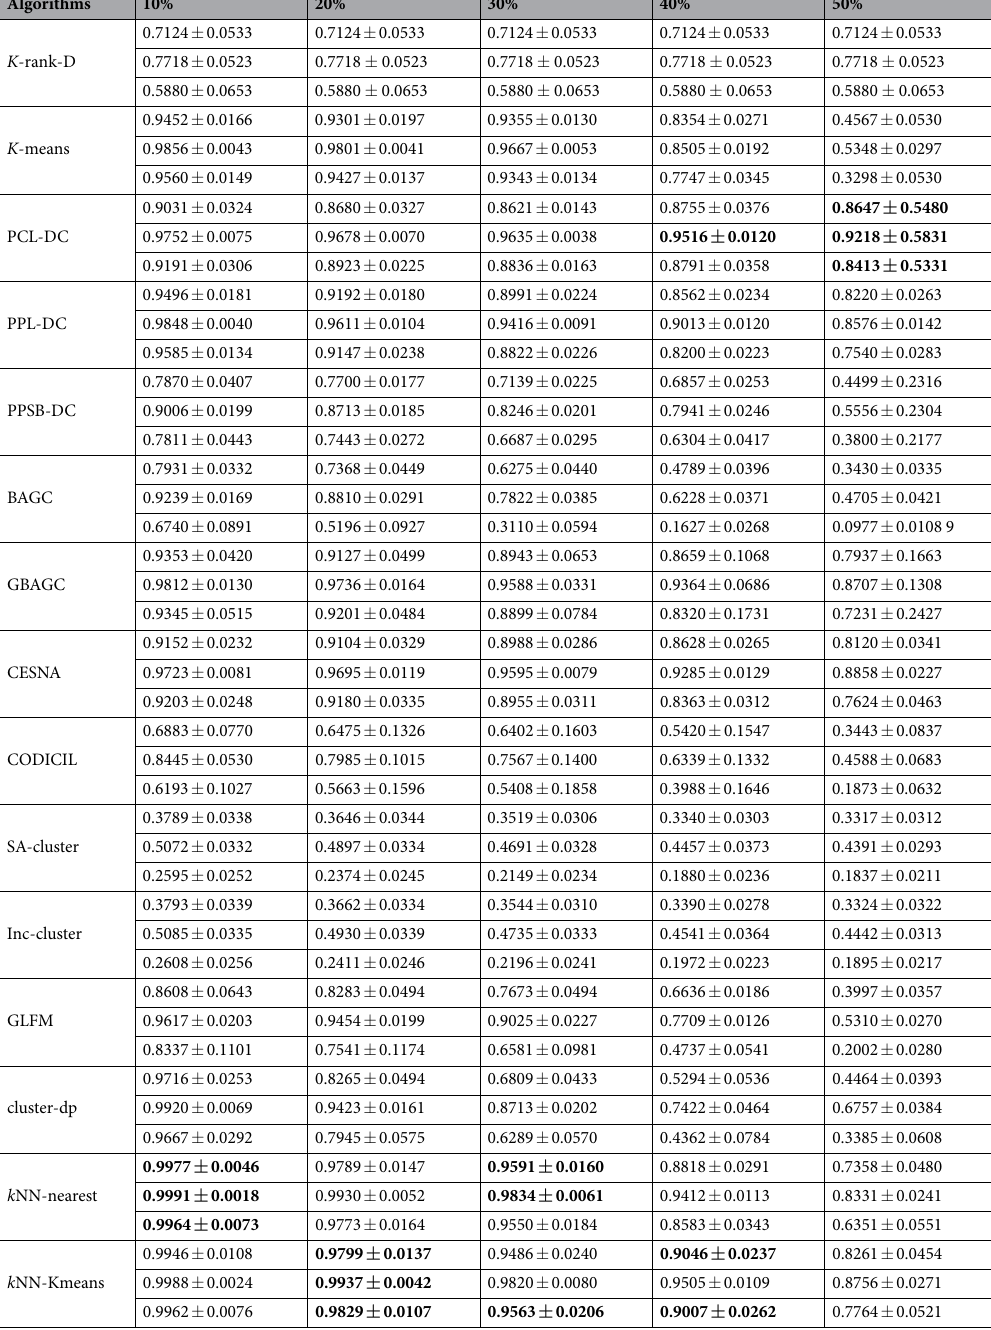
Table 1. Results on LFR networks with binary attributes, μ =